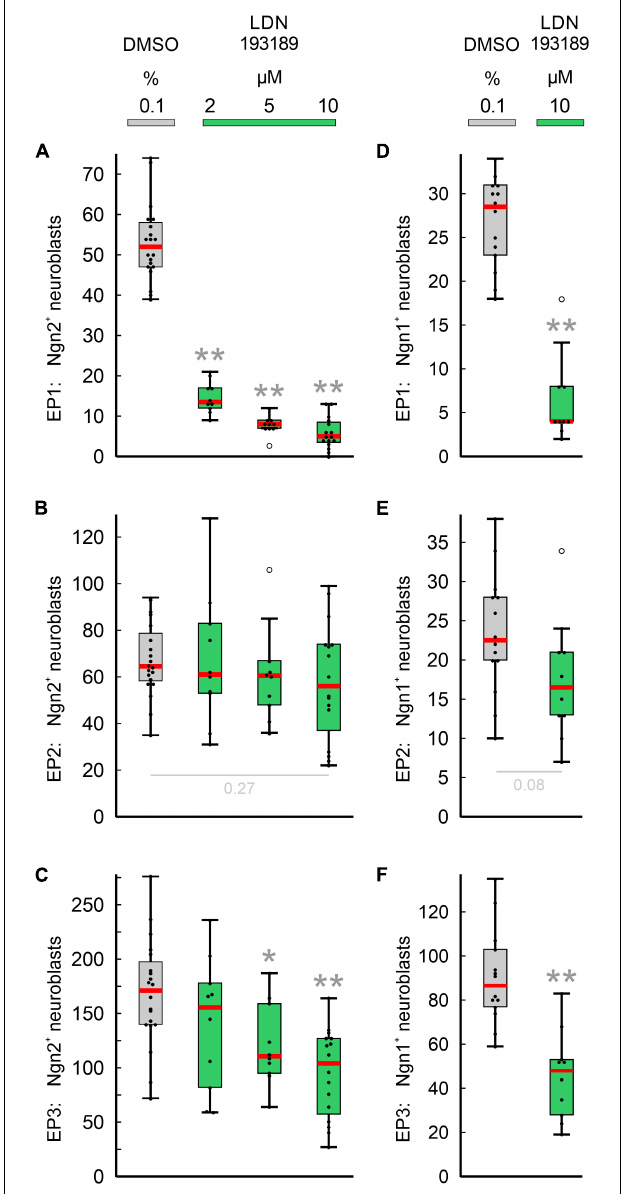
FIGURE 5 | Impact of pan-BMPR inhibition on the neurogenesis of epibranchial placodes (EP) in 9–14 somite mouse embryos, cultured for 24 h. Box plots indicate the numbers of Neurogenin (Ngn)2 + (A–C) or Ngn1 + (D–F) neuroblasts in EP1 (A,D) , EP2 (B,E) , or EP3 (C,F) following exposure to either dimethyl sulfoxide (DMSO) only (control; gray), or increasing doses of LDN193189 (green). Significant differences between each treatment group and the controls are indicated by gray asterisks (* P < 0.05, ** P < 0.001; Mann–Whitney test). Whiskers, lower and upper extremes; box limits, 25th and 75th percentiles; red center lines, medians; black dots, data points; open circles,